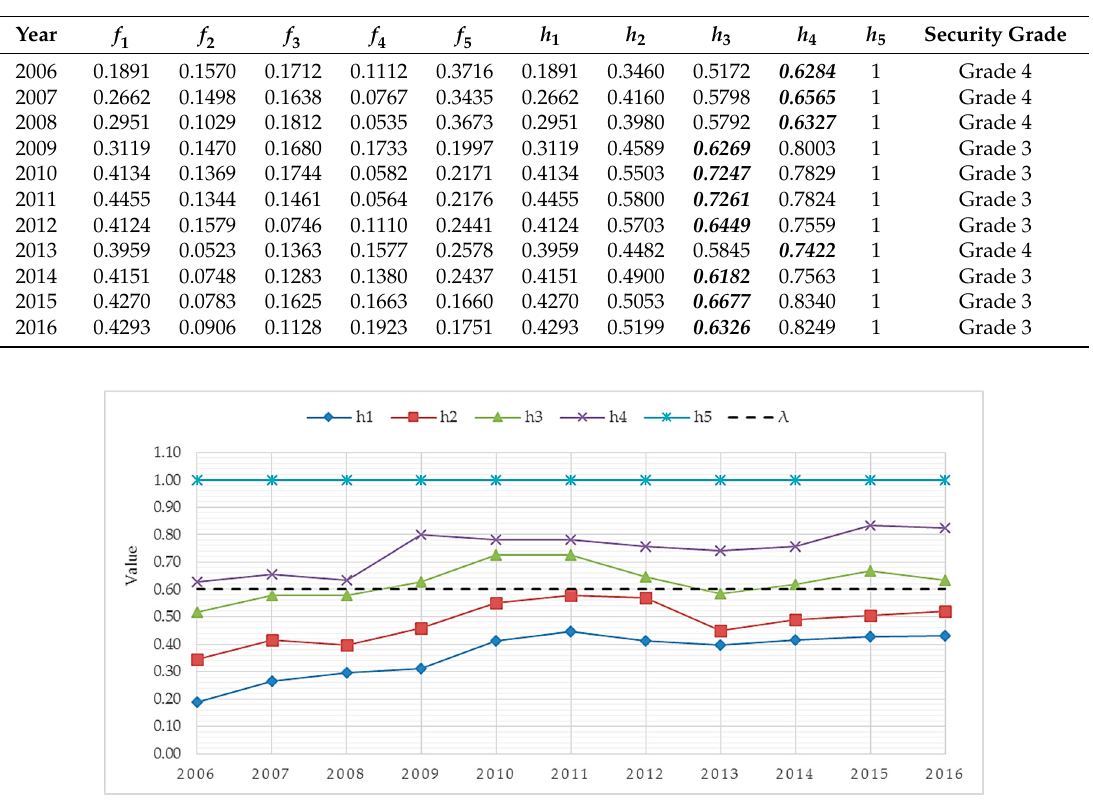
Figure 3. Cumulative connection degree trends from 2006 to 2016 in Luoyang.